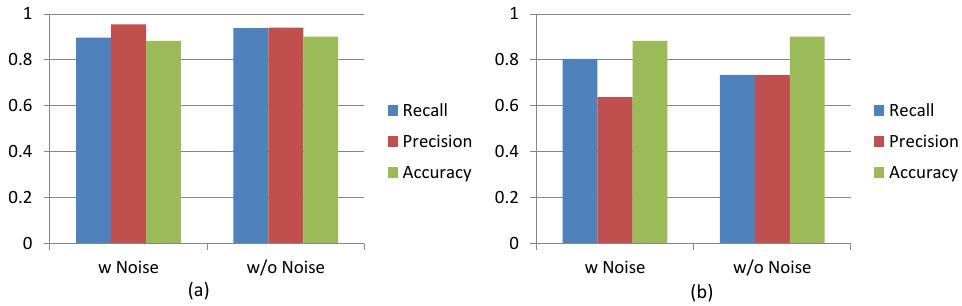
Figure 10. Average of precision, recall and accuracy for detecting ( a ) unusual events and ( b ) normal events using CI.